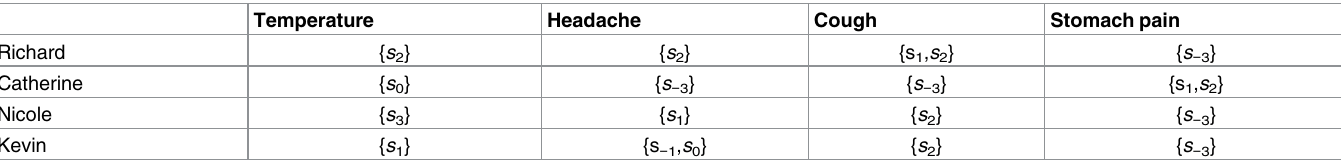
Table 2. Symptoms characteristic for the considered patients in terms of